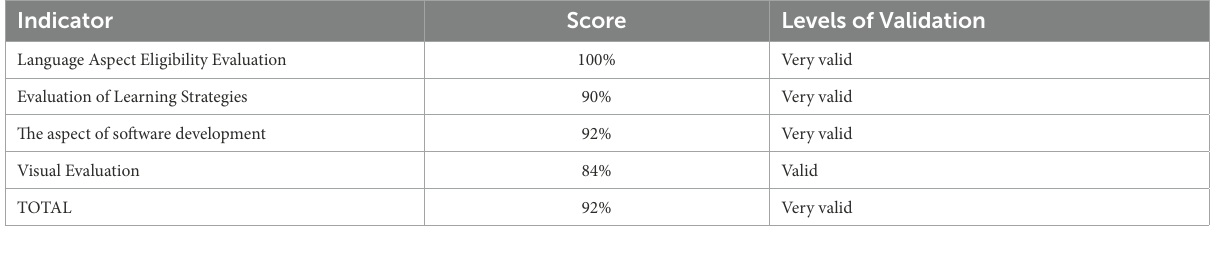
TABLE 7 Expert validation results recapitulated.